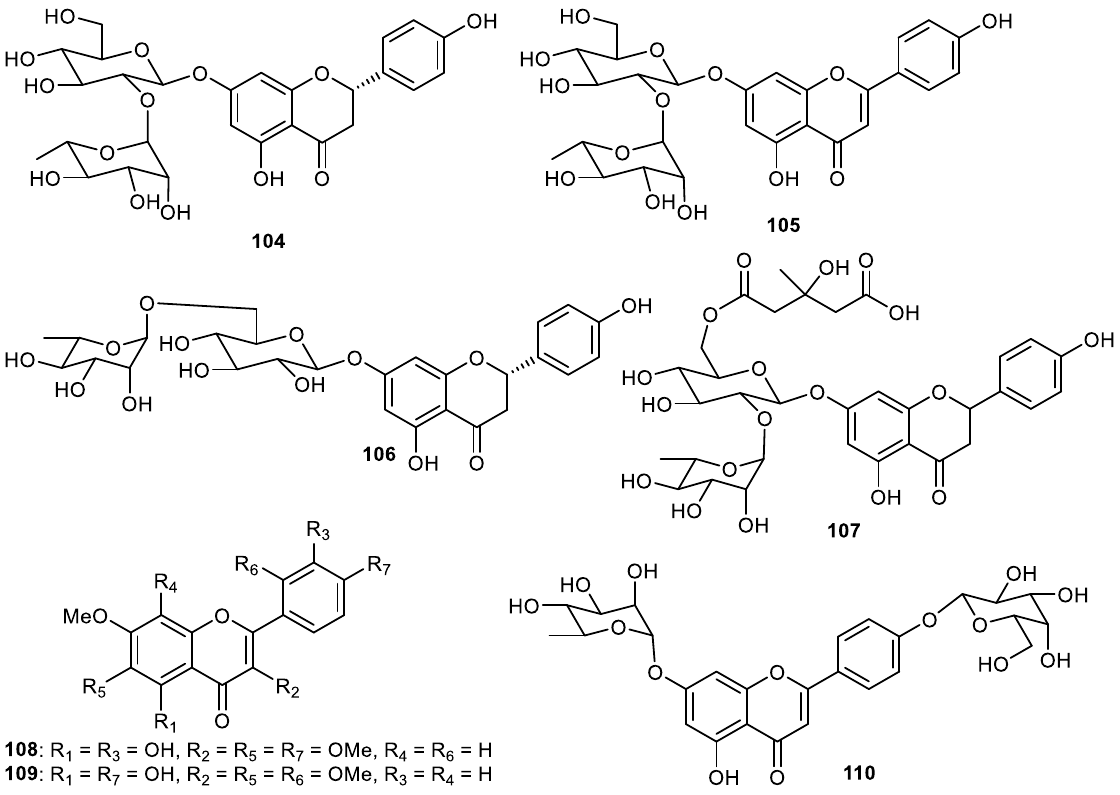
Figure 13. Structures of flavonoids 104 – 110 .